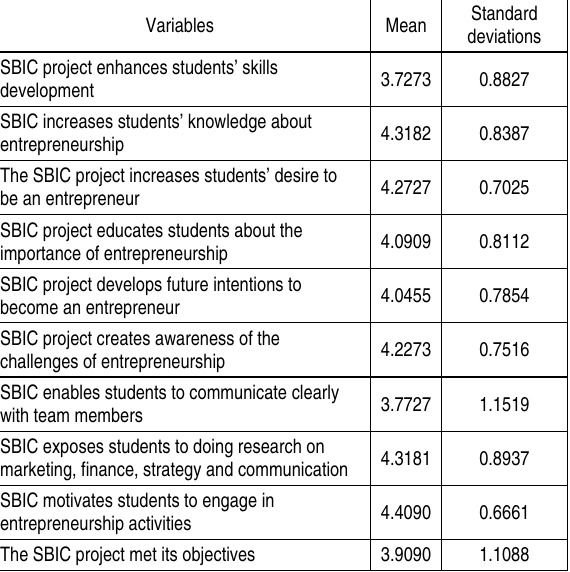
Table 16. Means and standard deviations of the impact of SBIC project on future